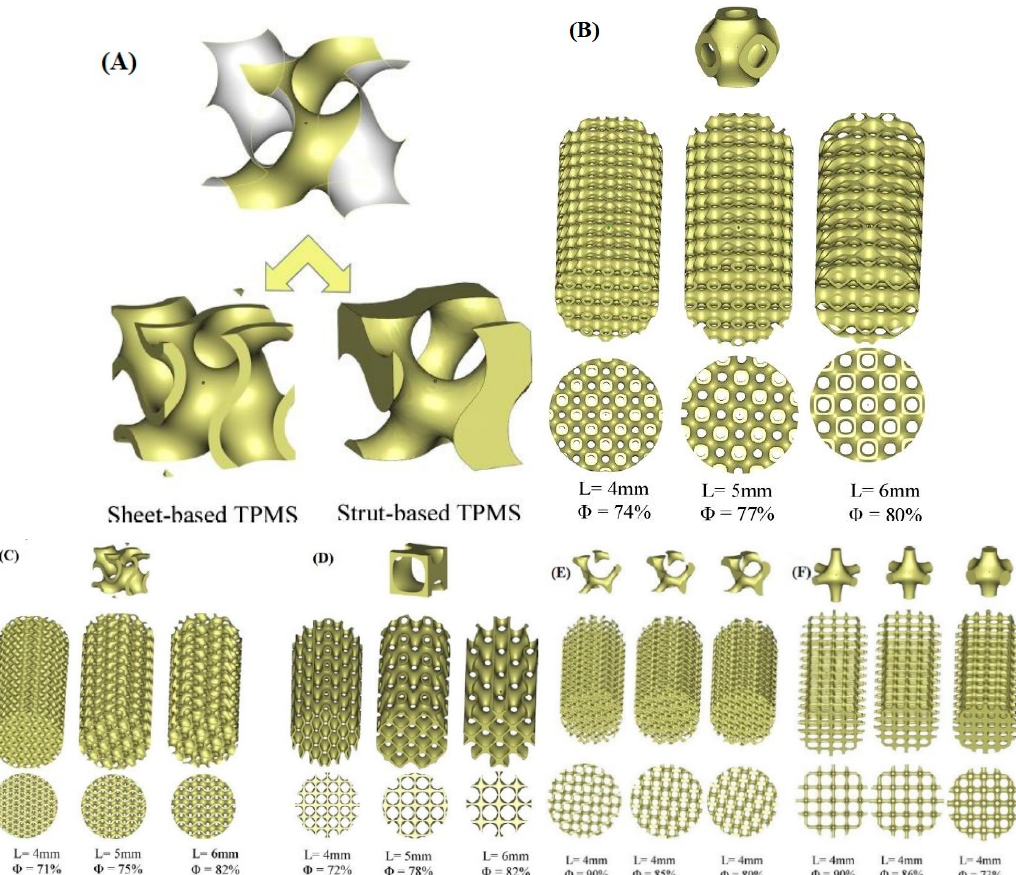
Figure 12. ( A ) Illustration of sheet-based TPMS and strut-based TPMS structures with different unit cell sizes (L) and macroporosities ( Φ ). ( B ) Primitive sheets, ( C ) gyroid sheets, ( D ) crossed layers of parallel (CLP) sheets, ( E ) gyroid struts and ( F ) primitive struts. Reproduced with permission from [168]. Copyright The American Ceramic Society, 2019.